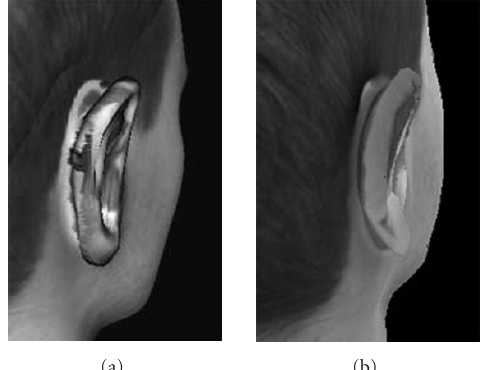
Figure 18: The e ff ect of using synthetic texture. (a) Simple texture mapping. (b) Improved result by using the public UV plane and the synthetic texture mapping.